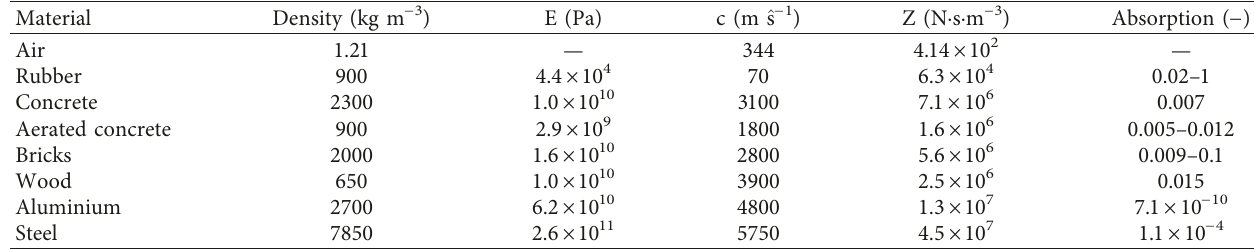
Table 2: Typical physical properties of typical materials [26, 27].